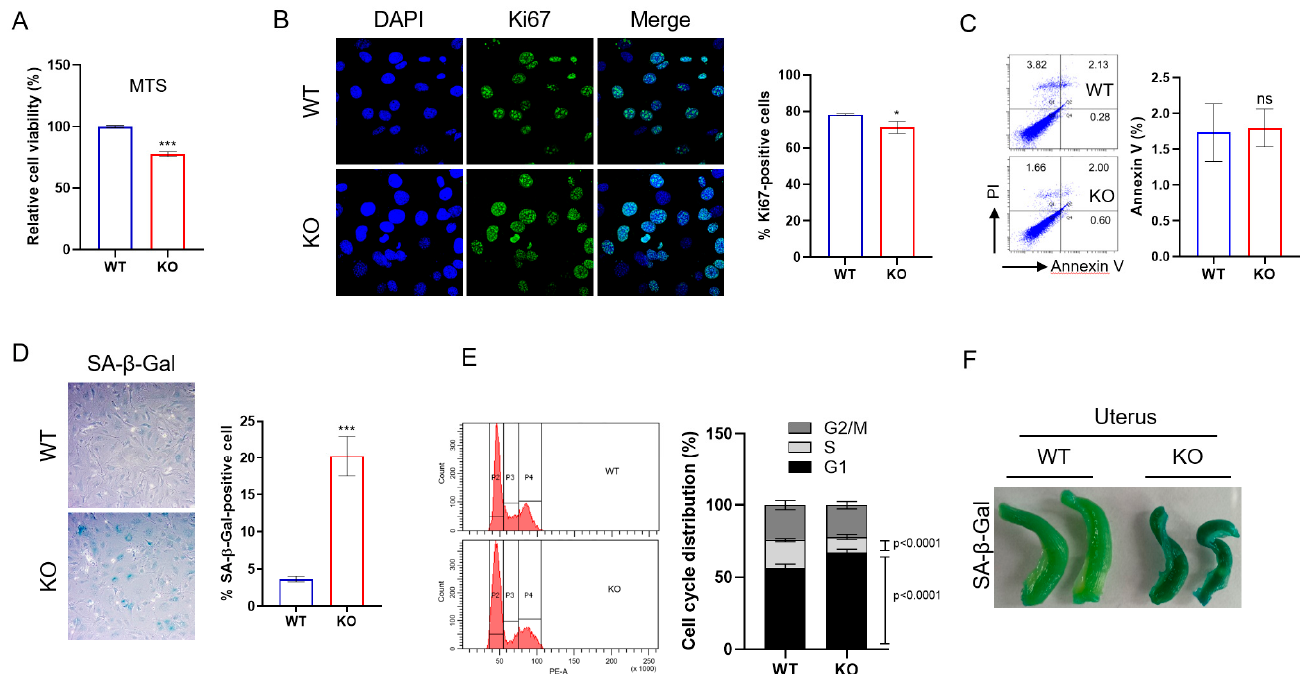
Figure 3. Effects of DRG2 deficiency on the proliferation, apoptosis, and senescence of endothelial cells. Lung endothelial cells (mLECs) derived from wild-type and DRG2 − / − mice were cultivated un- der normal conditions as described in the Section 4 without any treatment. The mLECs were analyzed by ( A ) MTS assay (n = 3 independent experiments in each group) and ( B ) Ki67 staining for cell proliferation (n = 40 cells per 3 independent experiments in each group), ( C ) Annexin-V staining and FACS analysis for apoptosis (n = 3 independent experiments in each group), ( D ) senescence-associated β -gal (SA- β -gal) staining for cellular senescence (n = 120 cells per 3 independent experiments in each group), and ( E ) FACS analysis for cell cycle arrest (n = 10 independent experiments). ( F ) Detection of SA- β -gal activity in uteruses from wild-type and DRG2 –/– mice. Images in ( B , D ) are representative (Original magnification 600× and 200×, respectively) of Ki67-stained cells and SA- β -gal-stained cells, respectively. The data are expressed as the mean ± SD. * p < 0.05; *** p < 0.001. ns, not significant.